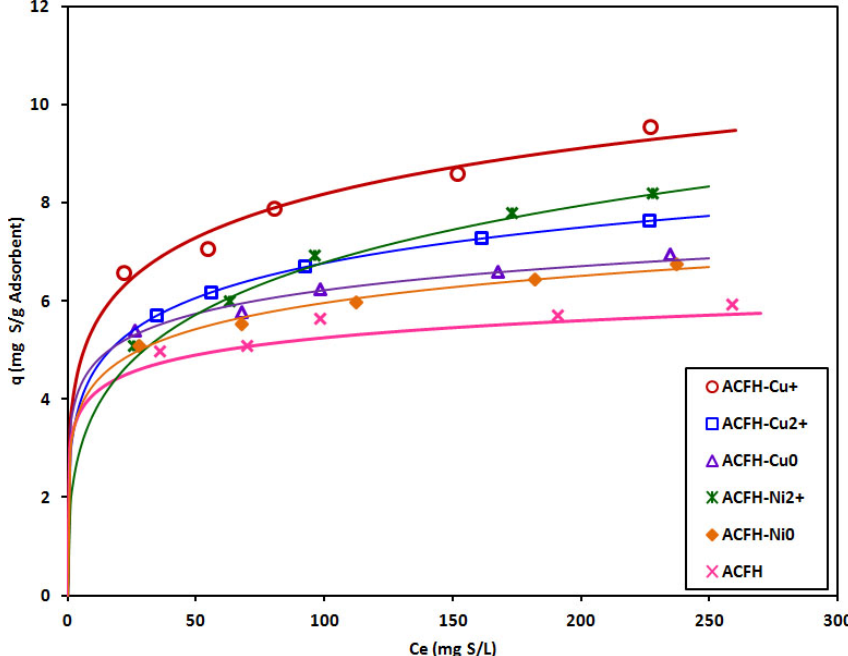
Figure 4. Adsorption isotherms of BT onto activated carbon fibers impregnated with different copper and nickel species. Solid lines represent Langmuir-Freundlich fit of the